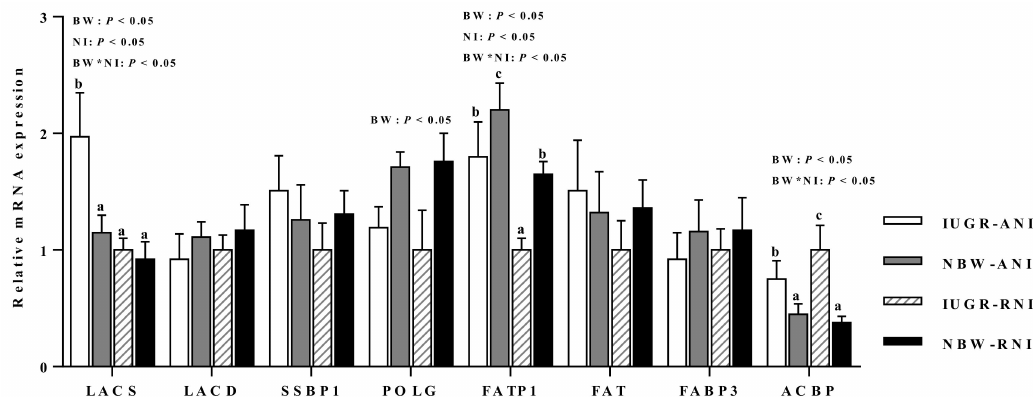
Figure 2. E ff ects of the level of nutrient intake on lipids metabolism related genes expression in psoas major muscles of intrauterine growth-retarded (IUGR) and normal-birth weight (NBW) piglets. ANI, adequate nutrient intake; RNI, restricted nutrient intake; BW, birth weight; NI, nutrient intake; LACS , long-chain acyl-CoA synthetase; LACD , long-chain acyl-CoA dehydrogenase; SSBP1 , single-stranded DNA-binding protein 1; POLG , DNA polymerase gamma; FATP1 , fatty acid transport protein 1; FAT , fatty acid translocase; FABP3 , fatty acid binding protein 3; ACBP , acyl-CoA binding protein. a,b,c Means within a gene with di ff erent superscripts di ff er ( p < 0.05). E ff ect of birth weight was significant for LACS , POLG , FATP1 , and ACBP ( p < 0.05). E ff ect of NI was significant for FATP1 and LACS ( p < 0.05). Interactions between birth weight and NI were significant for mRNA abundance of FATP1 , ACBP , and LACS ( p < 0.05).